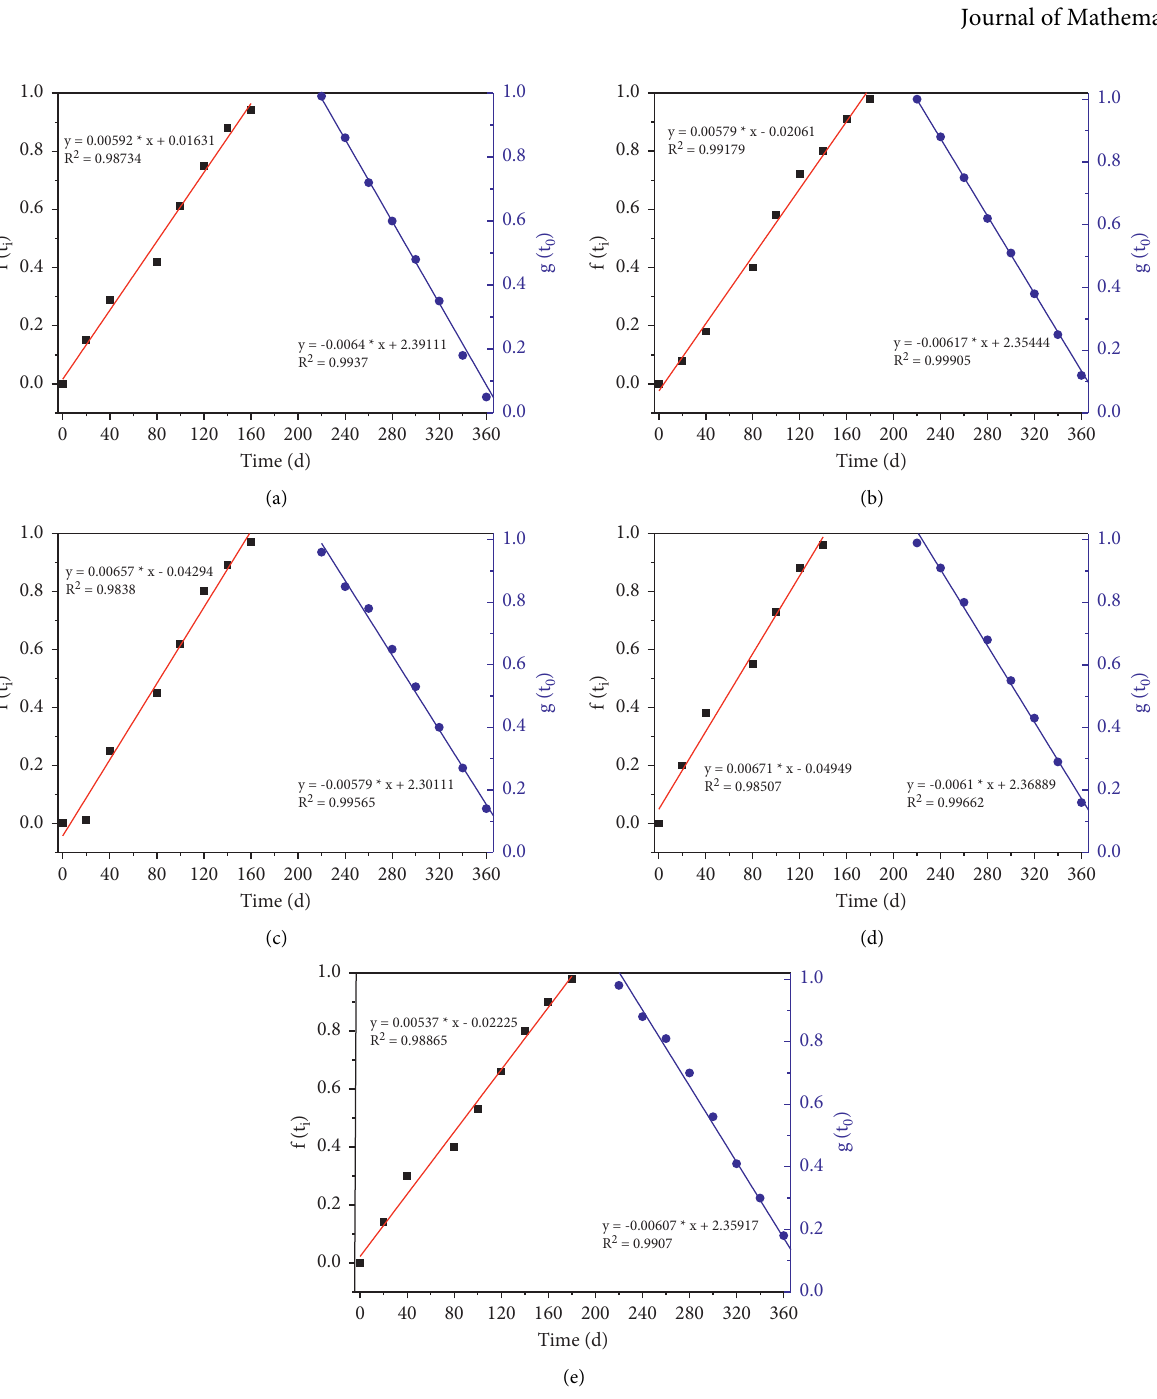
Figure 4: Membership functions of fuzzy variables in different urban areas: (a) Zhongyuan district, (b) Jinshui district, (c) Erqi district, (d) Gongyi city, and (e) Xinzheng